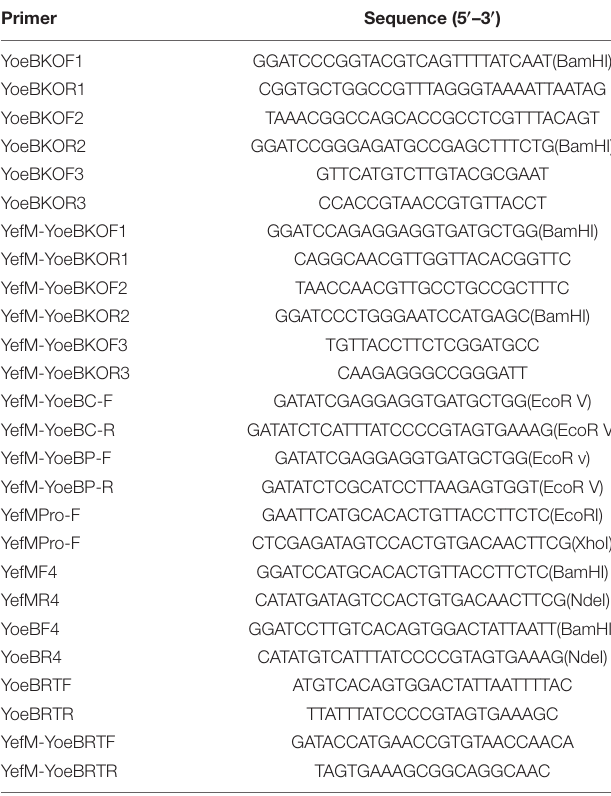
TABLE 1 | Primers used in this study.